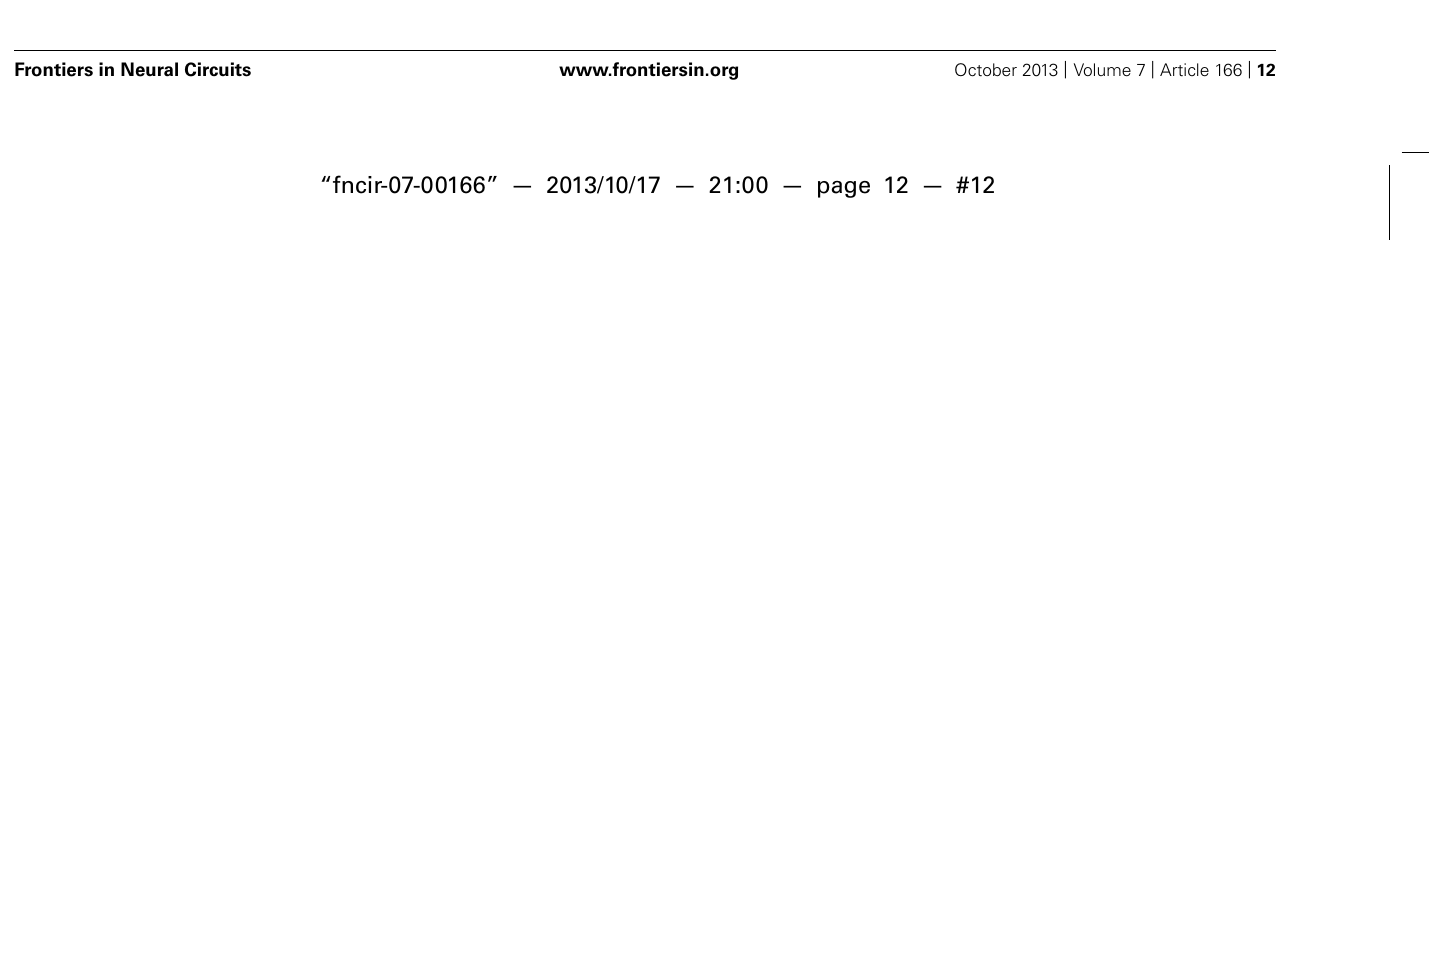
transform. (C) Spectrogram made from the frequency-specific envelopes outputted from the DRNL model. Each row of the plot is an envelope outputted from one discrete DRNL frequency channel. Note that the different frequency channels of the DRNL model overlap in frequency ranges and thus smear the spectrogram plot in the frequency dimension. (D) Neural representation of the spectrotemporal features of activity recorded across all 277 sites. Each row is a PSTH recorded from each ICC site for a specific best frequency region. dB FS decibels relative to full scale in which 0 dB FS corresponds to the maximum